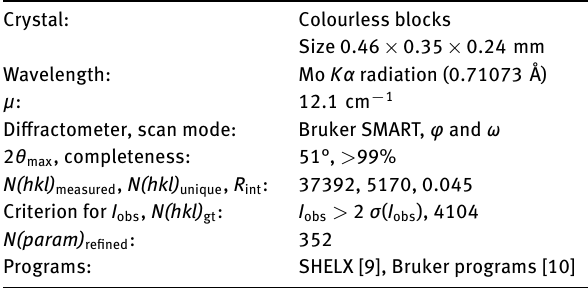
A part of the title crystal structure is shown in the figure. Tables 1 and 2 contain details of the measurement method and a list of the atoms including atomic coordinates and displacement parameters. Table 1: Data collection and handling.